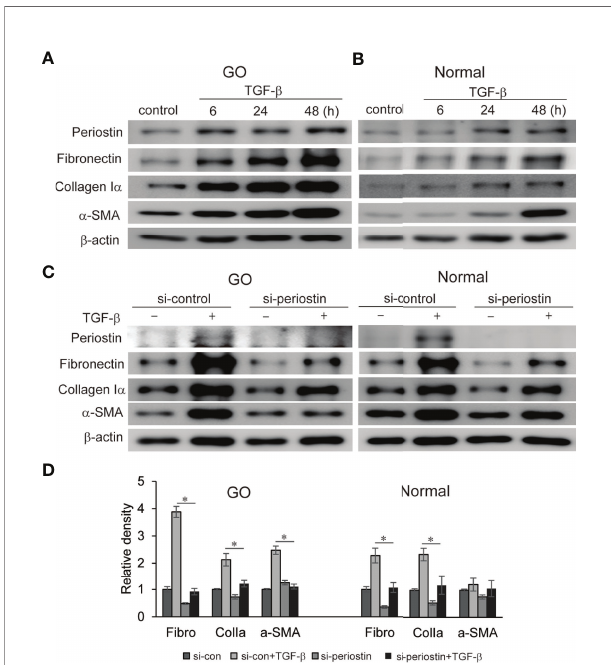
FIGURE 3 | Effect of silencing periostin on production of TGF- b -induced pro fi brotic proteins in GO and normal fi broblast. (A, B) Orbital fi broblasts from GO patients (n=3) and normal patients (n=3) were treated with 5 ng/ml TGF- b for 6-48 hours. Production of periostin was increased in a time dependent manner, more predominantly in GO orbital fi broblasts. (C, D) Knockdown of periostin by siRNA transfection ameliorated TGF- b -induced production of pro fi brotic protein in Western blot analyses. Fibronectin (Fibro) and collagen I a (Colla) expression was suppressed in both GO and normal cells, and a -SMA expression was inhibited in GO cells. The representative gel images are also shown, and the results from orbital fi broblasts are presented as the mean density ratio ± SD, normalized to the level of b -actin in the same sample. ( *p < 0.05 vs. TGF- b -stimulated